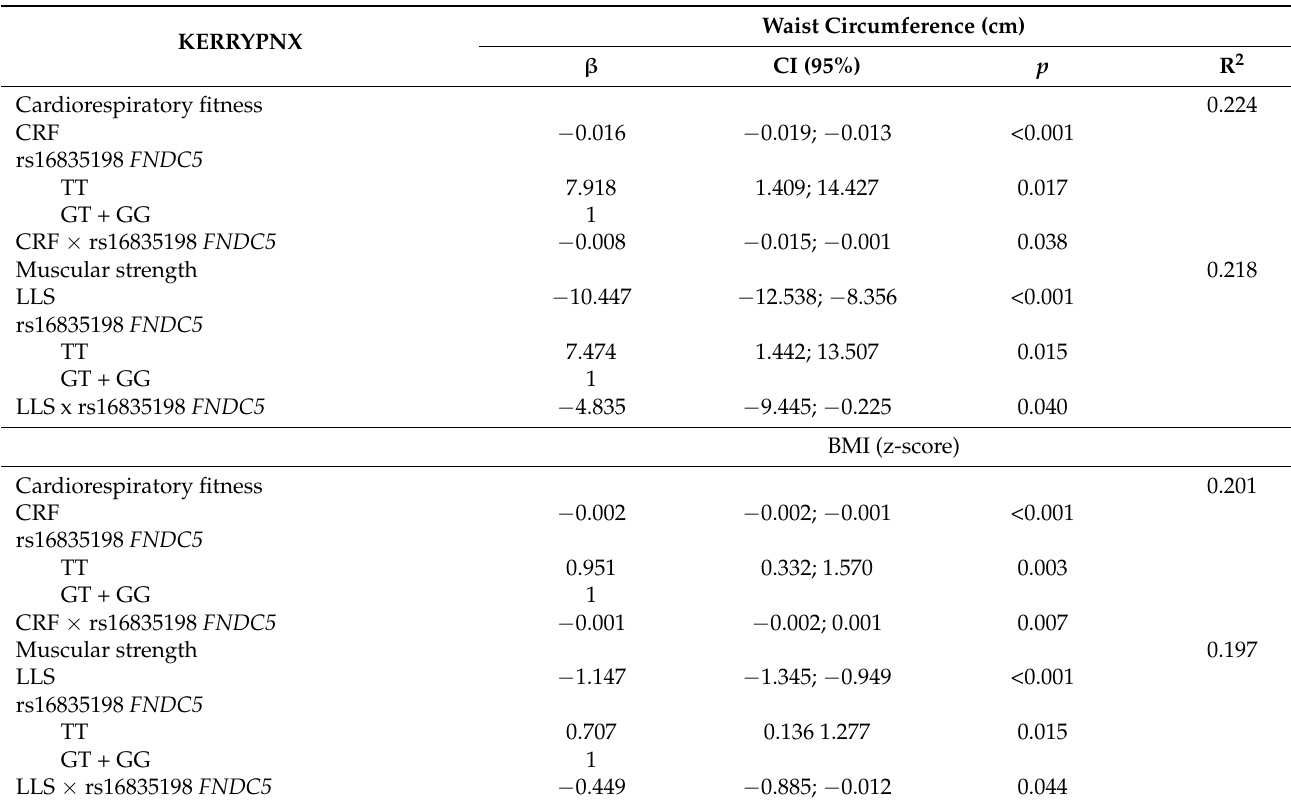
Table 2. Moderation of cardiorespiratory and muscular strength in the relationship between rs16835198 FNDC5 and adiposity